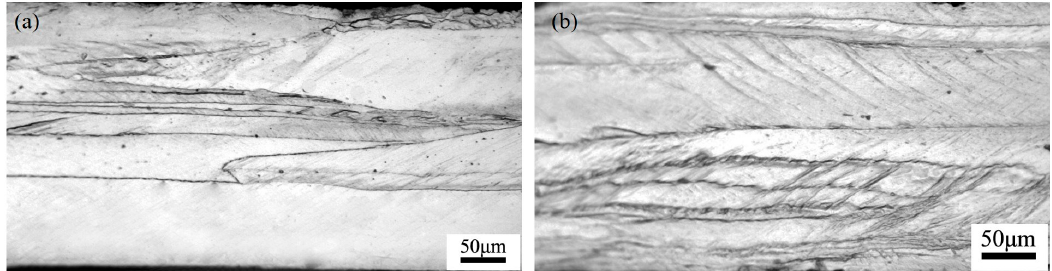
Figure 1. Microstructure of warm-rolled sheets: ( a ) 0Cu; and ( b ) 0.5Cu.